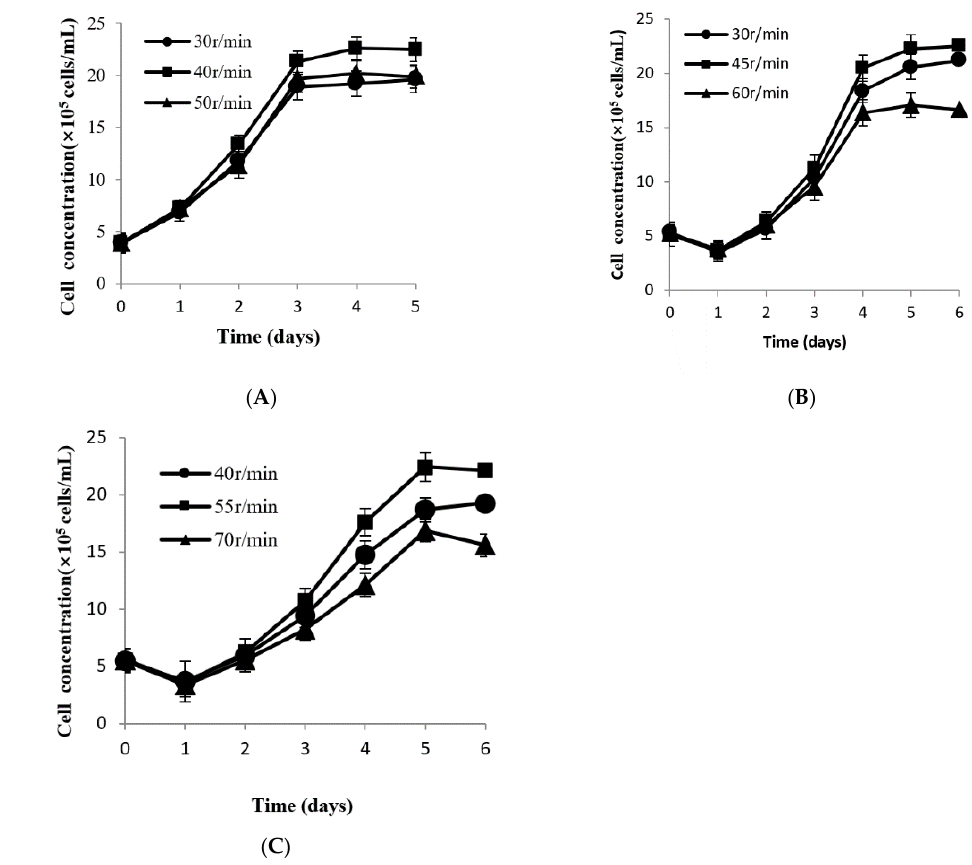
Figure 7. Growth curve of CPB cells at different agitation rates. ( A ) The 125 mL flask; ( B ) the 500 mL flask; ( C ) the 3 L bioreactor. Bars show the mean ± SD, n =3.